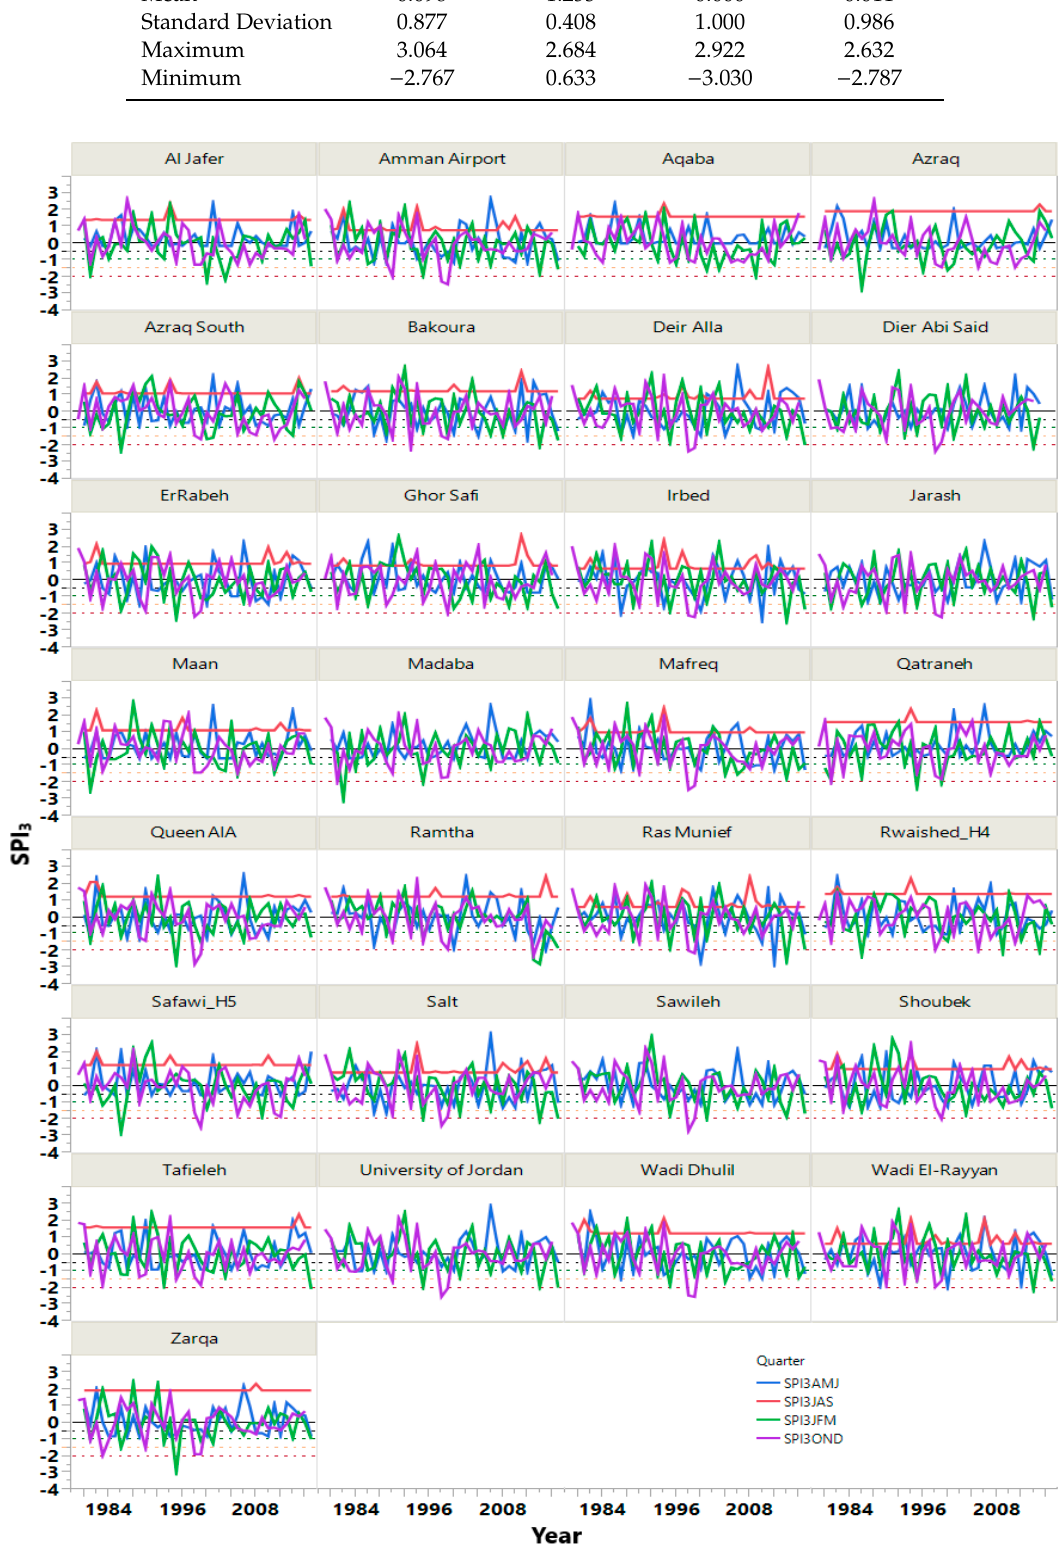
Figure 7. Standardized precipitation index of quarter periods (SPI 3 ) values 1980–2017.